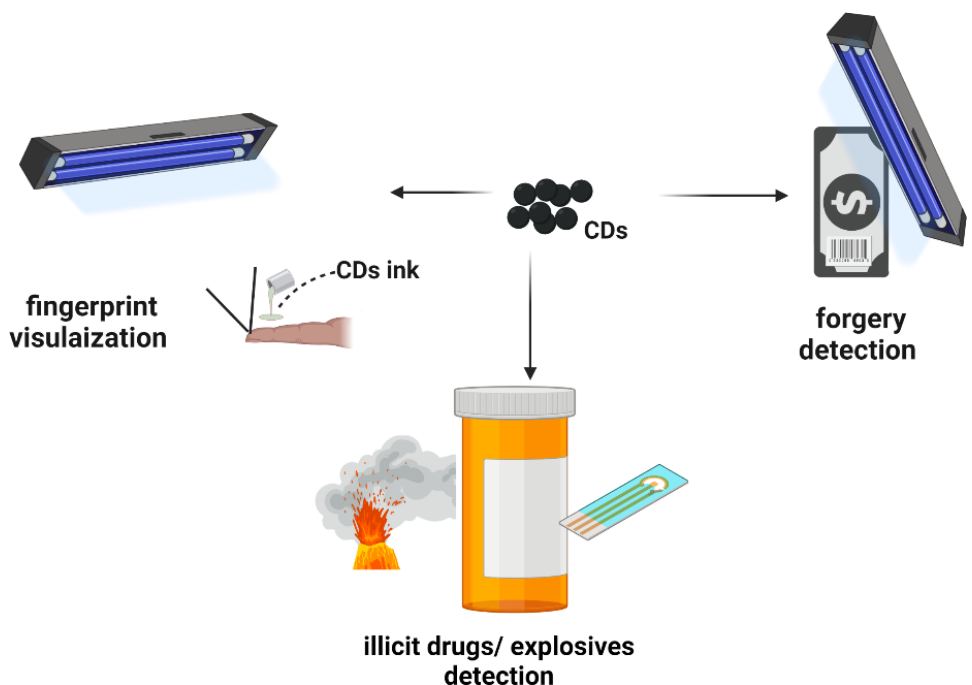
Figure 5. The possible role of carbon dots (CDs) in counterfeit detection. The Figure was created with BioRender.com (accessed on 1 September 2022).